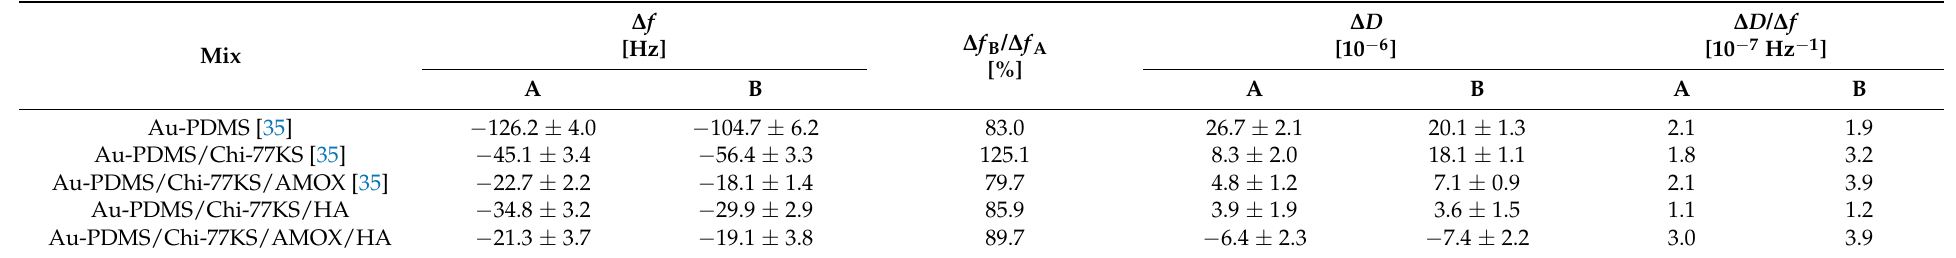
Table 3. Mix frequency change ( ∆ f ), dissipation change ( ∆ D ), desorption ratio ∆ f B / ∆ f A and ∆ D / ∆ f ratio (A is ∆ f and ∆ D before rinsing, B is the final ∆ f and ∆ D after rinsing).